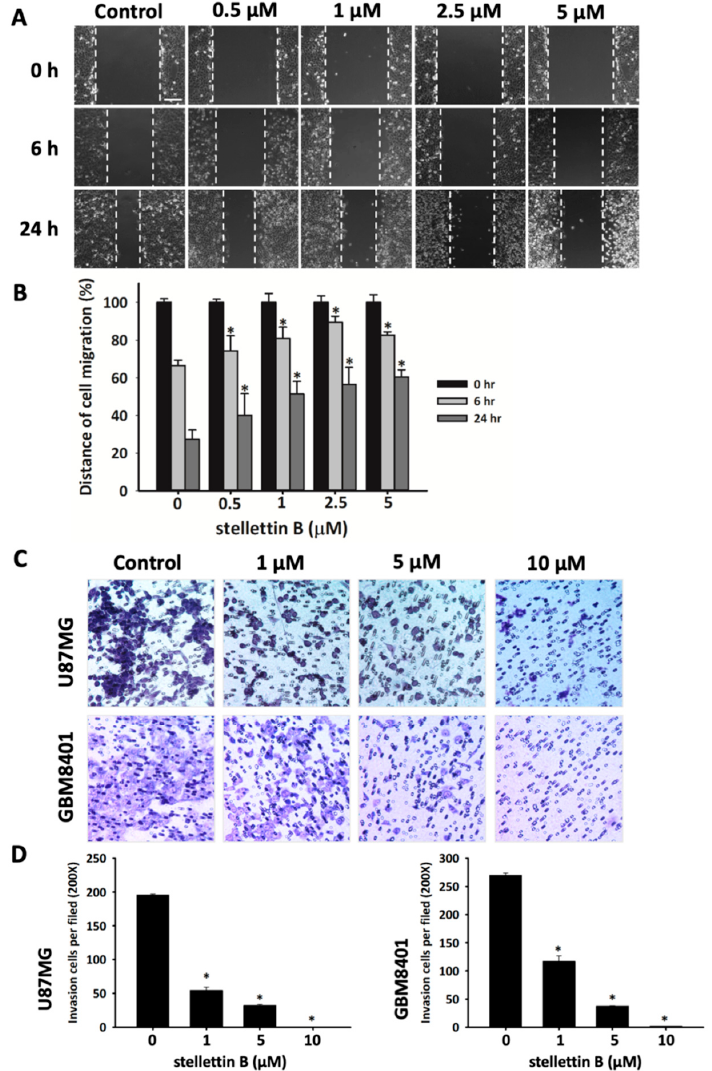
Figure 2. Stellettin B inhibits migration and invasion of glioblastoma (GBM) cells. ( A ) Scratch wound healing assay on GBM8401 cells treated with 0, 0.5, 1, 2.5, or 5 µ M stellettin B for 6 or 24 h. Scale bar = 200 µ m. ( B ) Distance of cell migration was quantified using SPOT Imaging Microscopy Imaging Software. The result is representative of three separate experiments and is presented as mean ± SD ( n = 3). * p < 0.05 comparing starting time. ( C ) Cell migration was measured using a transwell chamber (8 µ m pore). U87MG and GBM8401 cells were treated with 0, 1, 5, or 10 µ M stellettin B for 24 h. Migrated cells were stained with Giemsa solution, magnification 200 × . ( D ) The number of migrated cells on the underside of the transwell insert was counted per file. Data are presented as mean ± SD ( n = 3). * p < 0.05 relative to